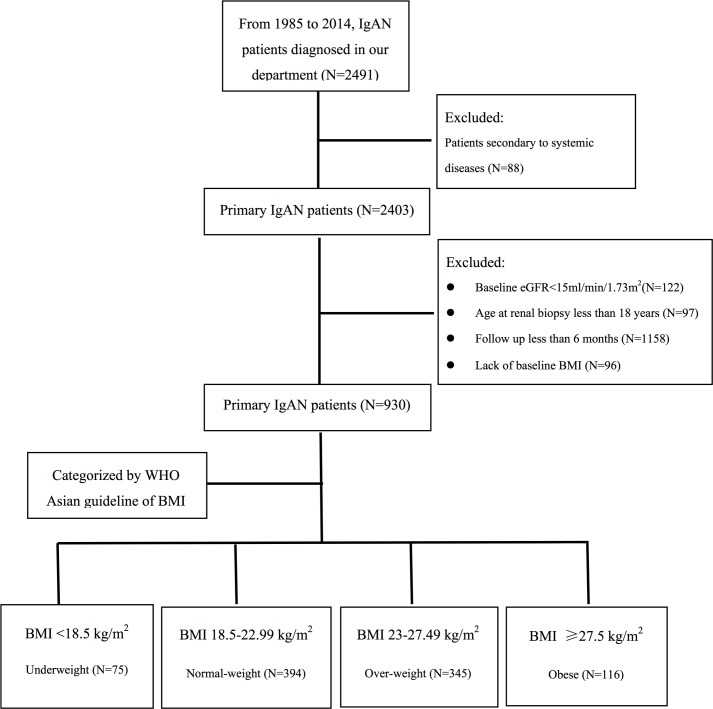
Screening, enrollment, and patients eligible for the analysis.The exclusion criteria were show as follows: secondary to system disease, baseline eGFR value of less than 15ml/min/1.732, biopsy age less than 18 years old, follow-up less than 6 months and lack of baseline BMI were excluded.